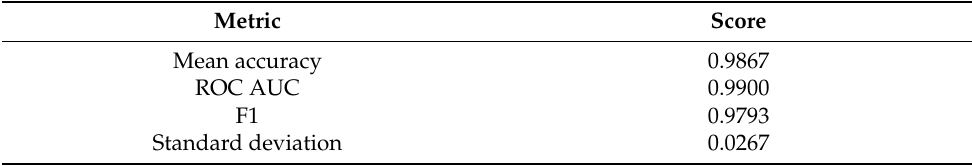
Table 3. Cross-validation evaluation